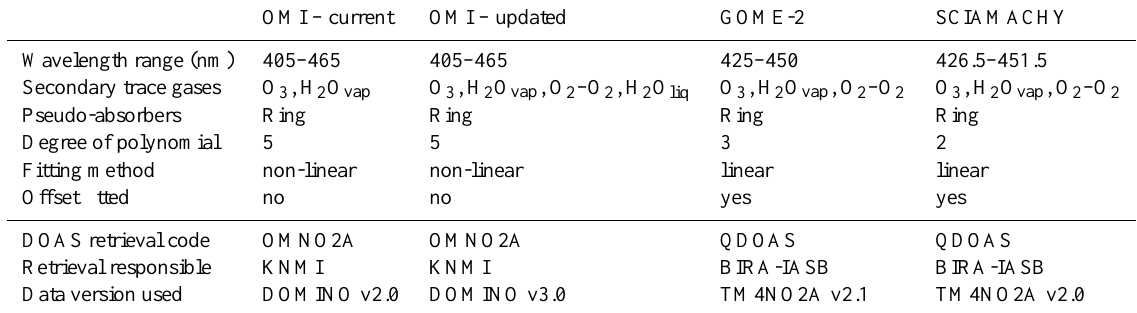
Table 1. Main settings of the DOAS retrieval of NO 2 slant column densities of the data versions used in this paper for the satellite instruments OMI, GOME-2 and SCIAMACHY; for OMI the current settings and the settings resulting from the discussion in this paper are given. OMI – current OMI – updated Wavelength range